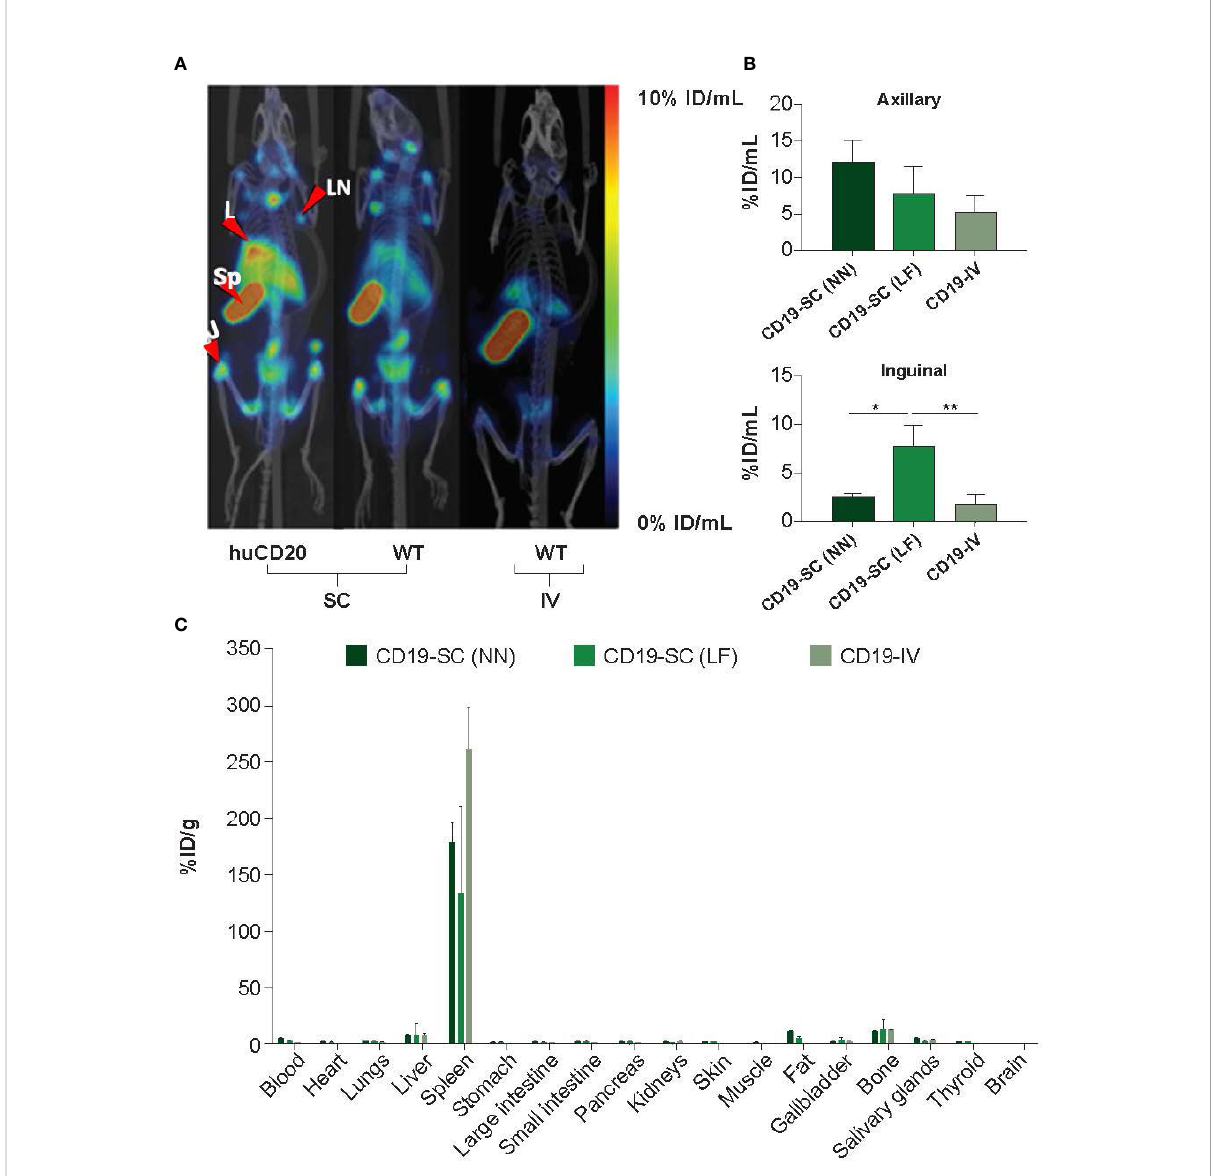
FIGURE 3 (A) Representative MIP SPECT/CT images of huCD20 and WT mice 72 h after SC or IV administration of 111 In-anti-mouse CD19. Prominent binding of 111 In-anti-CD19 is observed in lymph nodes of huCD20 and WT mice following SC administration, but not after IV administration. J = joint; L = liver, LN = lymph node, Sp = spleen. (B) Quantitative VOI analysis of SPECT/CT imaging. (C) Uptake of 111 In-anti-CD19 in the blood and tissue of WT mice 72 h after administration, as assessed by ex-vivo gamma counting analysis. LF = right lower fl ank, NN = nape of the neck. * p < 0.05; ** p < 0.01. Data represent mean ±